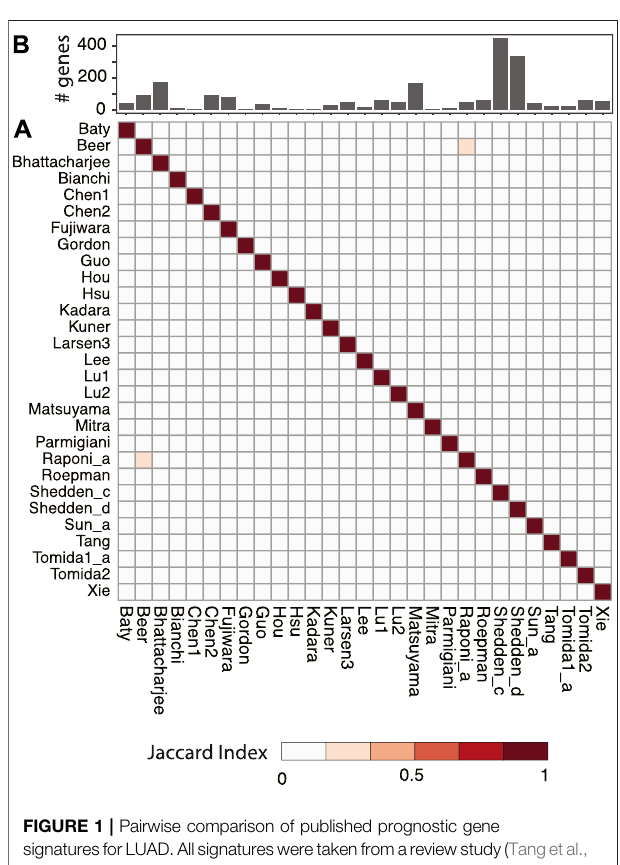
FIGURE 1 | Pairwise comparison of published prognostic gene signaturesforLUAD.Allsignaturesweretakenfromareviewstudy(Tangetal., 2017) and the original references were listed in Supplementary Table S1 . Jaccard index was used to quantify the level of overlap between two signatures and shown as a heatmap (A) . The number of genes in each signature was shown as a bar plot (B)